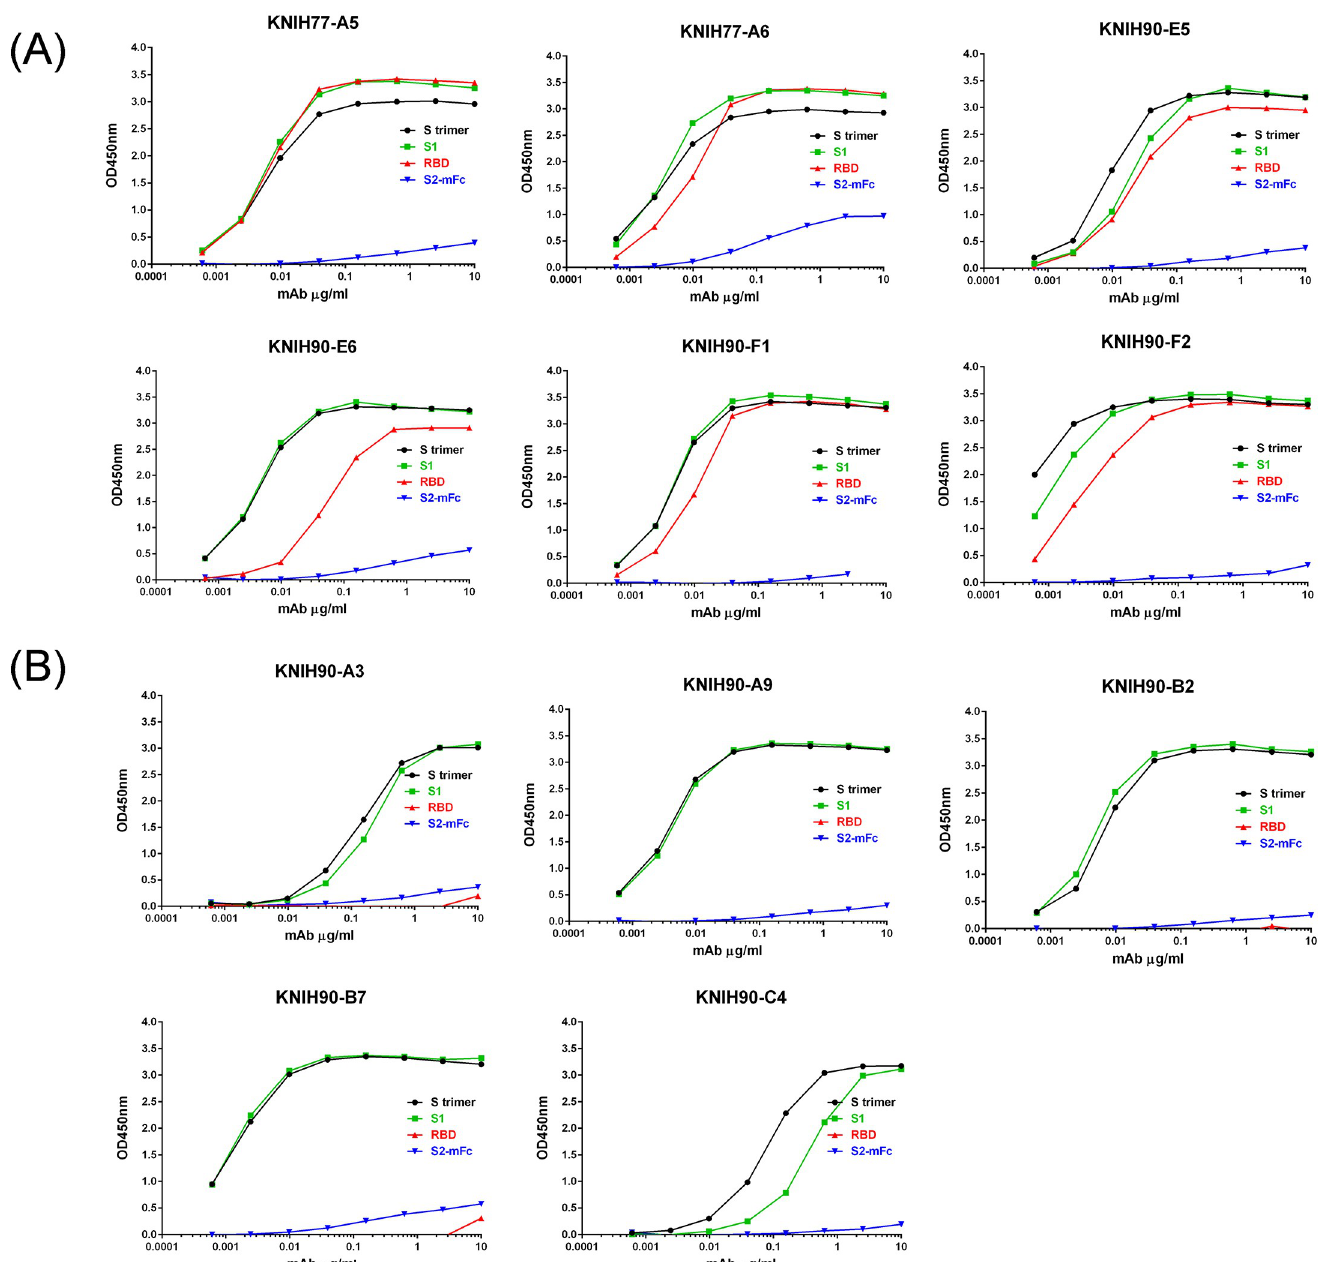
Fig 1. Binding of human mAbs to S1 and RBD of the MERS-CoV S protein. Binding specificity of the mAbs was assessed by ELISA with a soluble S-2P trimer, S1, RBD sub-domains, and S2-mFc. Among the 11 purified mAbs, six were specific to RBD and five were specific to S1 (non-RBD). RBD-specific mAbs bound to both RBD and S1 protein. No S2-specific mAbs (blue line) were identified. Data points represent the mean of three technical replicates with standard errors.